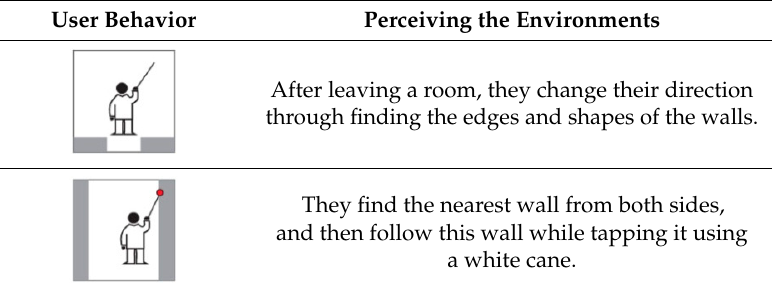
Table 2. Wayfinding behaviors of visually impaired people.